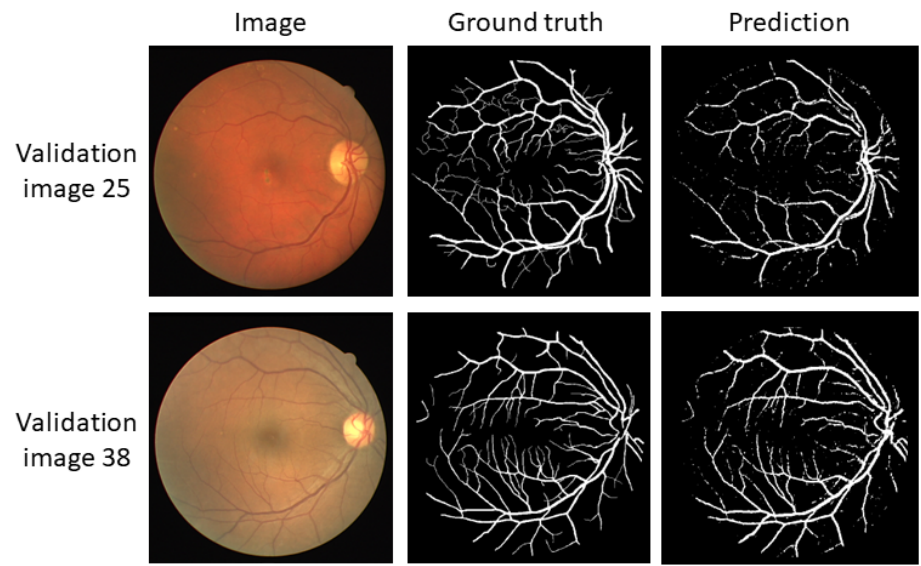
Figure 6. Two validation images, its real mask and the Swin-Unet prediction.